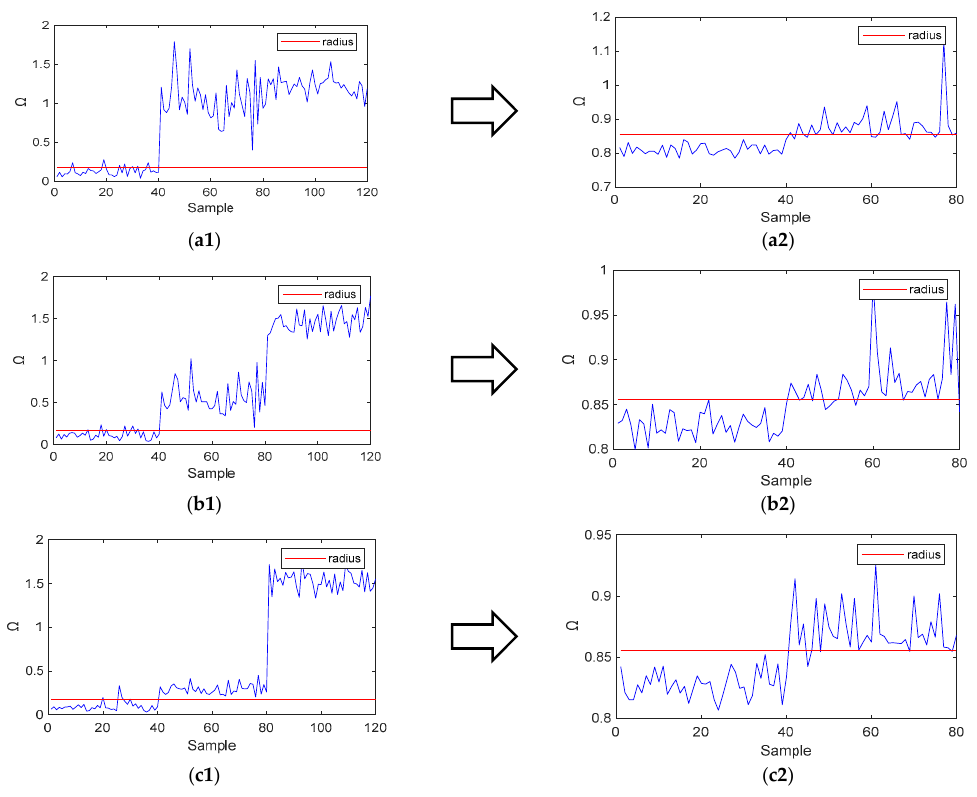
Figure 7. The results of the Cas-SVDD method for pipeline leak detection. ( a1 ) Cas-SVDD 1 (small leak); ( a2 ) Cas-SVDD 2 (small leak); ( b1 ) Cas-SVDD 1 (medium leak); ( b2 ) Cas-SVDD 2 (medium leak); ( c1 ) Cas-SVDD 1 (large leak); ( c2 ) Cas-SVDD 2 (large